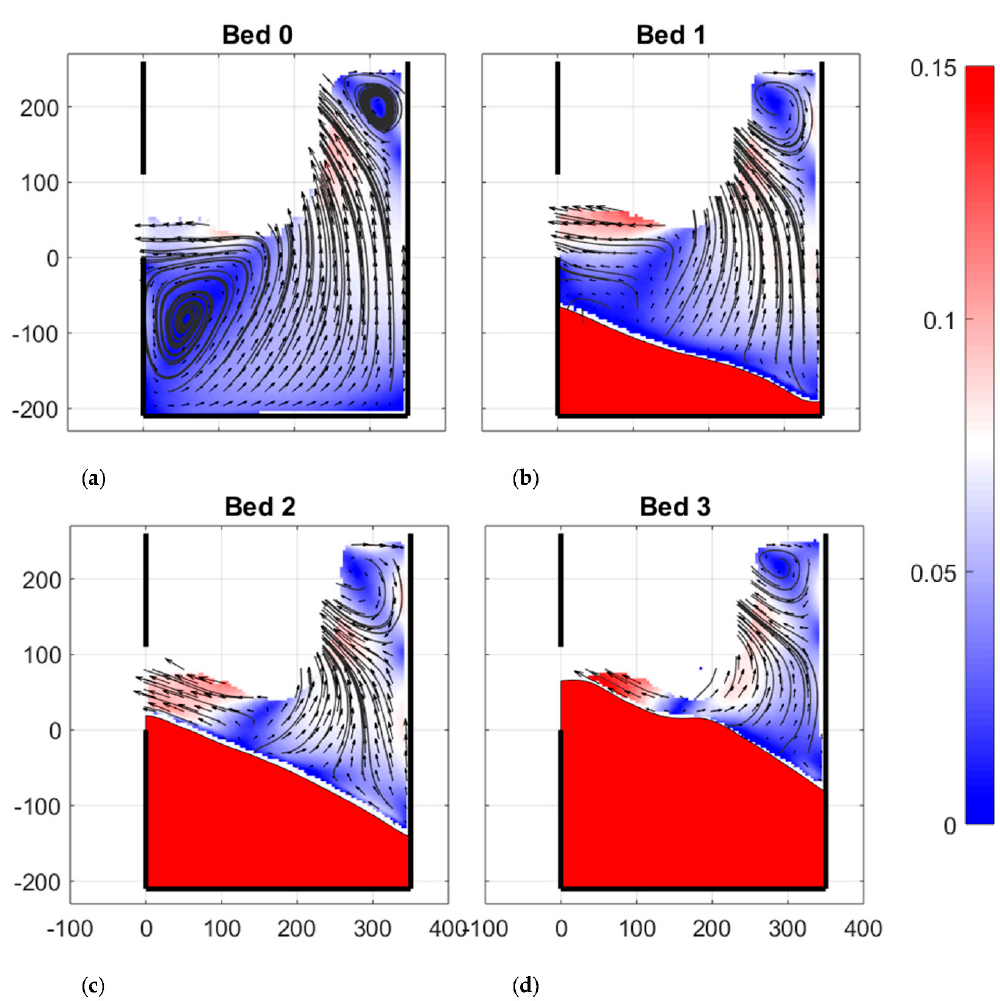
Figure 12. The effect of a growing sediment bed on the flow field. The sand traps in the figures are filled with sediment ( a ) 0% filled; ( b ) 24% filled; ( c ) 62% filled; ( d ) 91% filled. The velocities in Figure 12 represent mean velocities (averaged over 1000 frames captured at 3 Hz). Figure 13 shows the results of the LDA measurements, providing data on the mean velocity and turbulent fluctuations. The measurements for bed 3 contain an outlier in the mean velocity data, which is shown in another colour. This outlier is most likely due to air entrainment.